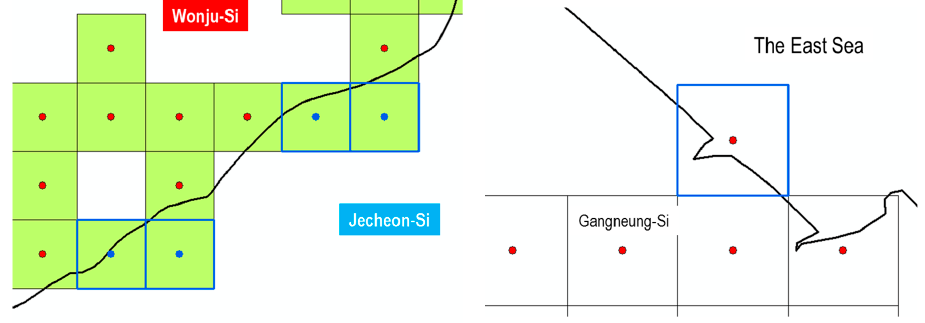
Figure 3. Assignment of 986,000 grids to administrative districts (Si, Gun, or Gu).